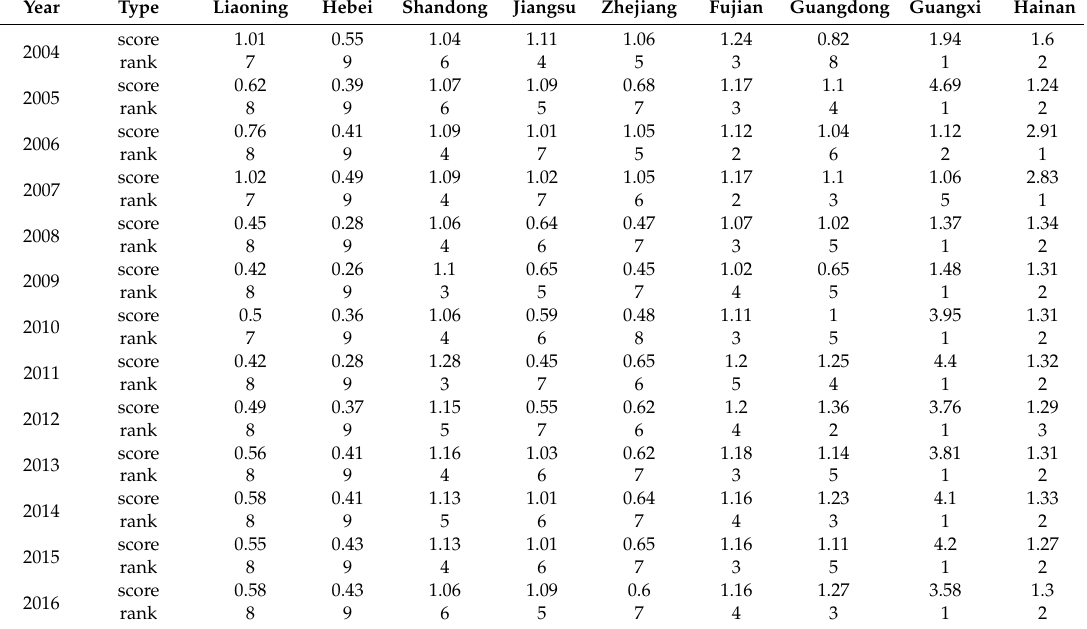
Table A1. Mariculture e ffi ciency in coastal areas of China,